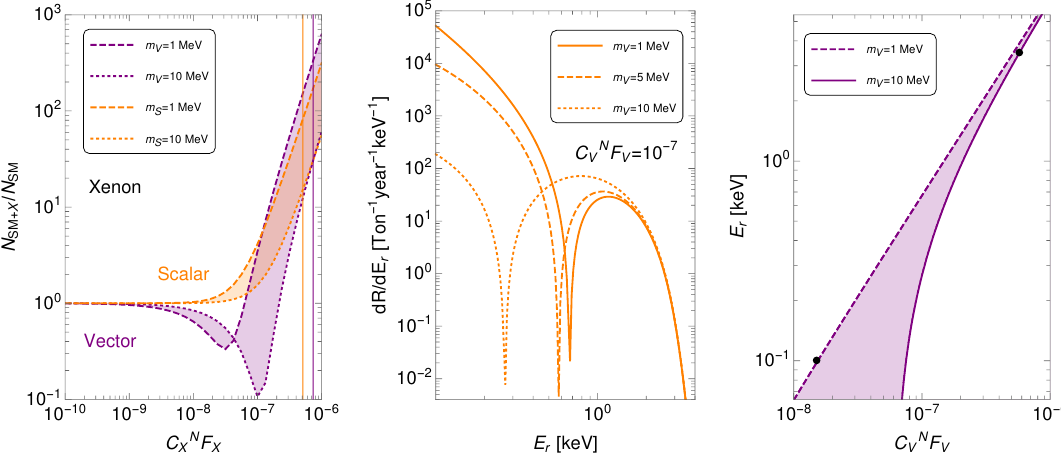
Figure 3 . Left graph : number of expected events normalized to the SM expectation for light vector (purple) and scalar (orange) mediators in a xenon detector assuming a one ton-year exposure and 100% detector e(cid:14)ciency. The result was obtained assuming a 10 (cid:0) 1 keV energy recoil threshold, X = V; S . The vertical orange and purple lines indicate COHERENT upper limits for scalar and vector couplings, respectively. Middle graph : recoil spectrum for di(cid:11)erent light vector mediator masses as a function of recoil energy. This result demonstrates the presence of dips in the vector spectrum, in contrast to the scalar case. Right graph : energy recoil region where dips are found in the light vector mediator case. The black dots located at ( C N F V ; E r ) = (1 : 5 10 (cid:0) 8 ; 10 (cid:0) 1 keV) and V (cid:2) ( C N F V ; E r ) = (5 : 8 10 (cid:0) 7 ; 3 : 5) keV (cid:12)x the boundaries where dips, though present, are no longer V (cid:2) observable in the recoil spectrum. See text (section 3.1) for further